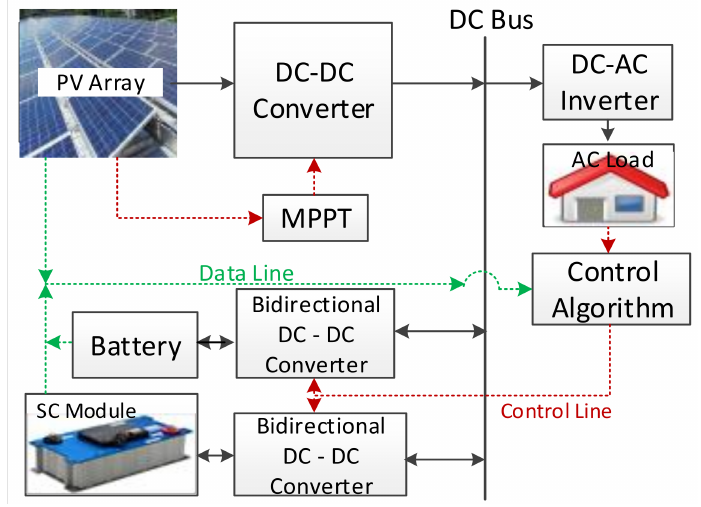
Figure 12. A sample PV-HESS microgrid system structure for domestic application [168].